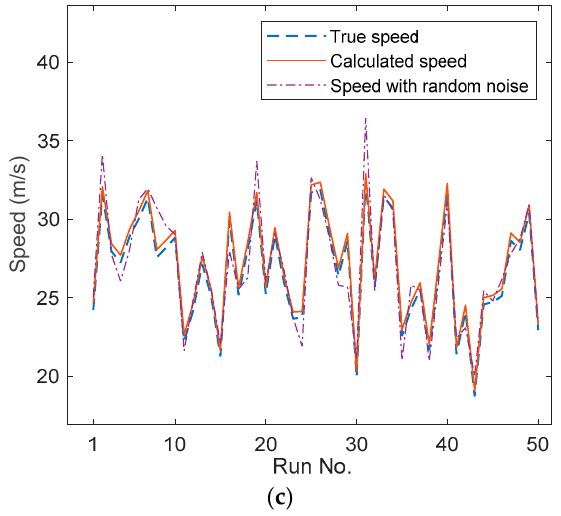
Figure 10. ( a ). Calculated vehicle masses for each of the 50 runs in the batch, running on Profile 1, State 7. ( b ). Calculated vehicle moments of inertia for each of the 50 runs in the batch, running on Profile 1, State 7. ( c ) Calculated vehicle speeds for each of the 50 runs in the batch, running on Profile 1, State 7.